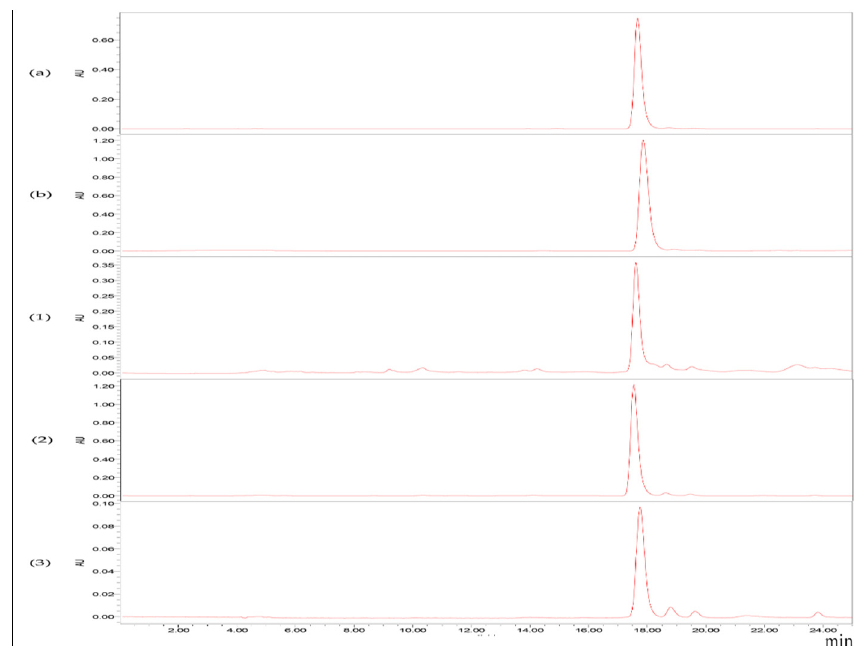
Figure 2. HPLC analysis of samples taken throughout the fractions obtained during the ODS chromatographic purification with three-step gradient (70%, 90%, and 100% in ethanol:water, v / v ). ( a ) Fucoxanthin (FX) standard solution with a concentration of 100 mg/L; ( b ) the S. horneri extract solution with an FX concentration of 139.84 mg/L; ( 1 ) the fraction eluted by ethanol:water (7:3, v / v ); ( 2 ) the 2-fold diluted fraction eluted by ethanol:water (9:1, v / v ); ( 3 ) the fraction eluted by absolute ethanol.